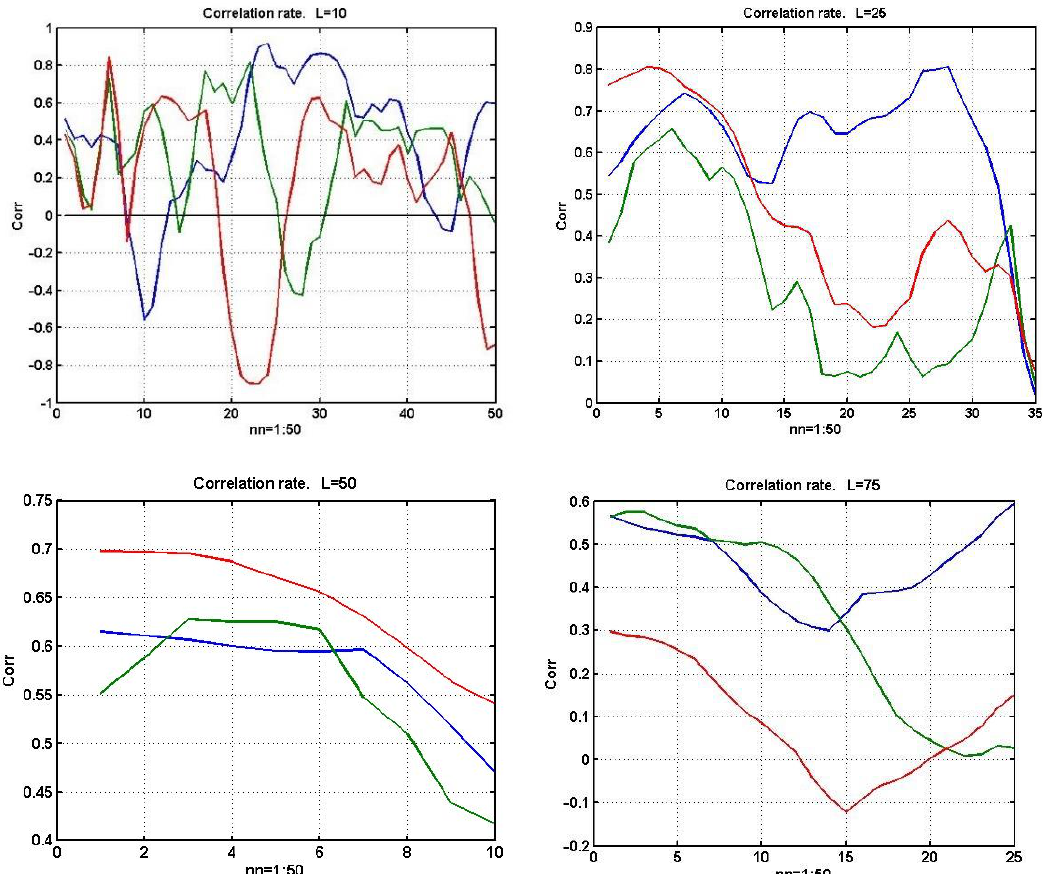
Figure 8. The change in the estimated pairwise correlation between two currency instruments on sliding observation windows of size L = 10, 25, 50, and 75 counts.